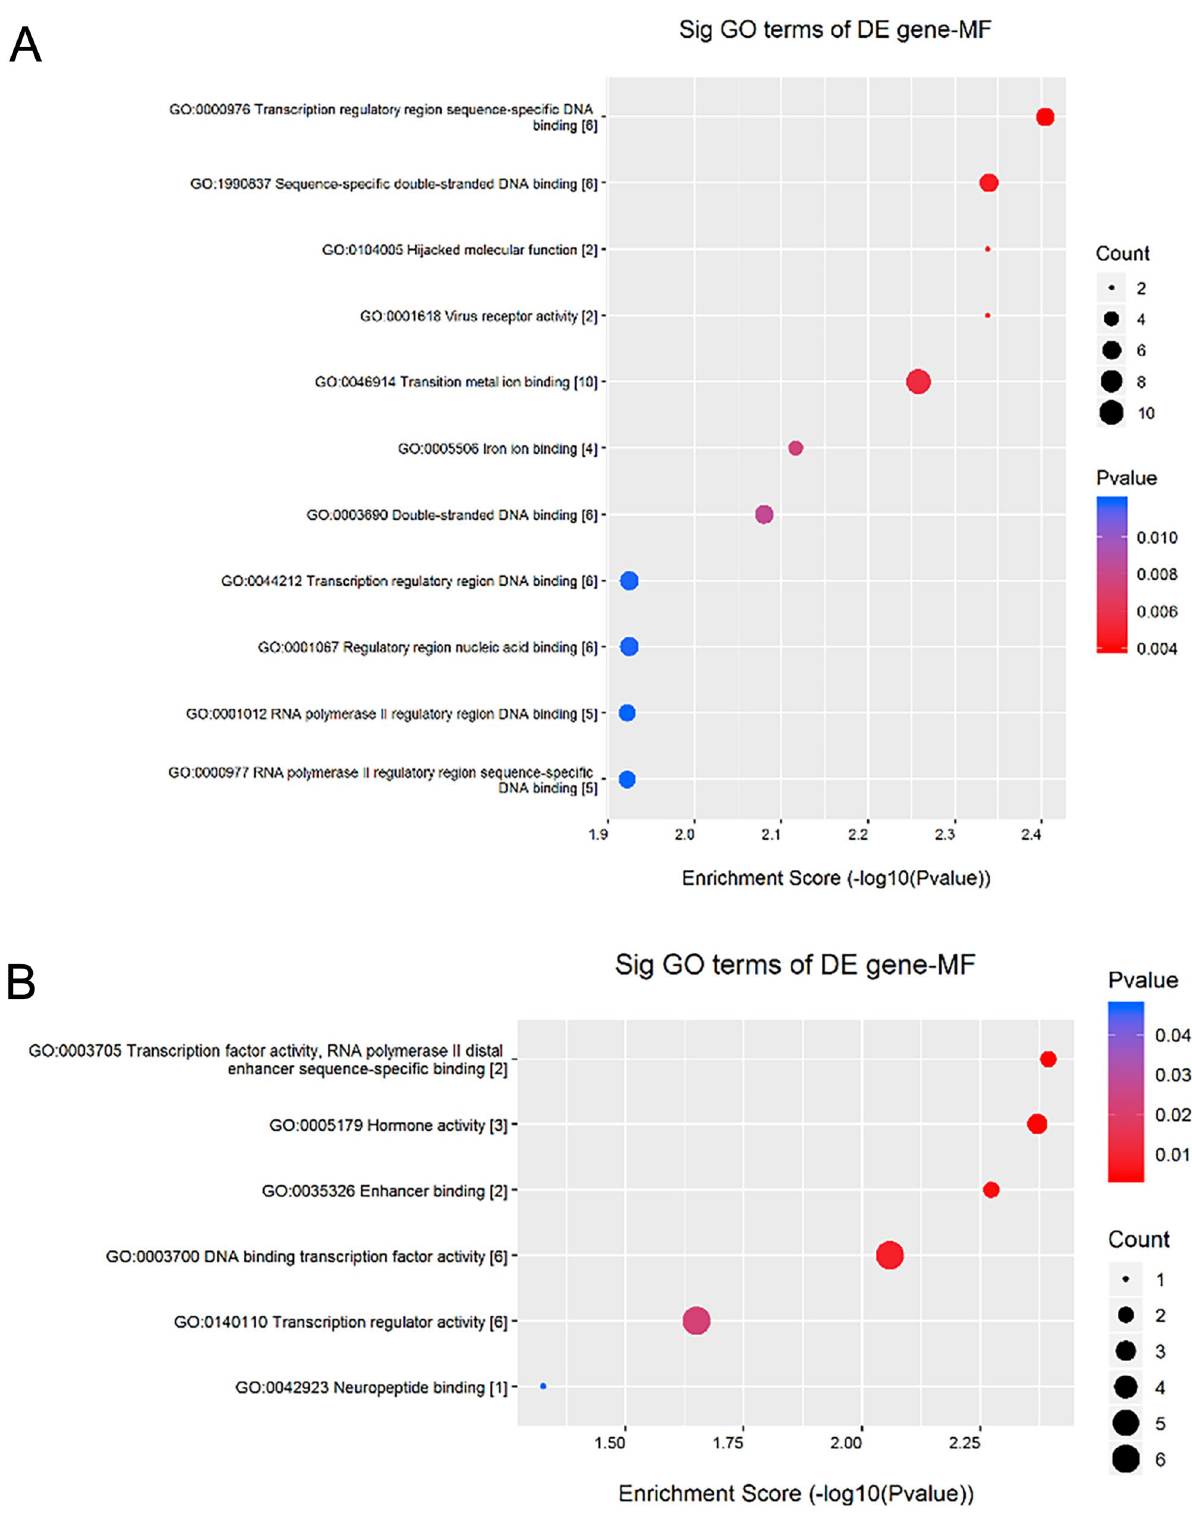
Figure 5. The molecular function enrichment analyses for the differentially expressed genes (DEGs) analysed by Gene Ontology (GO). ( A ) The top ten molecular functions with upregulated Enrichment Score Dot Plot. ( B ) The molecular functions with upregulated Enrichment Score Dot